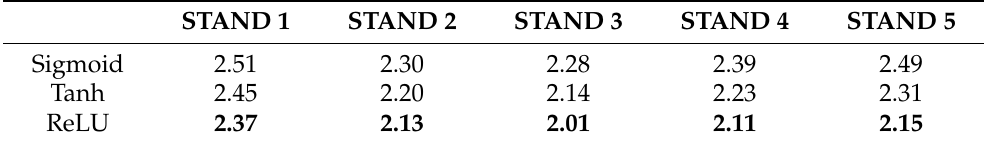
Table 5. Experimental results with various activation functions for the motor load prediction models. (The number of hidden layers: 1. The number of hidden nodes: 700. Learning rate: 0.001.)